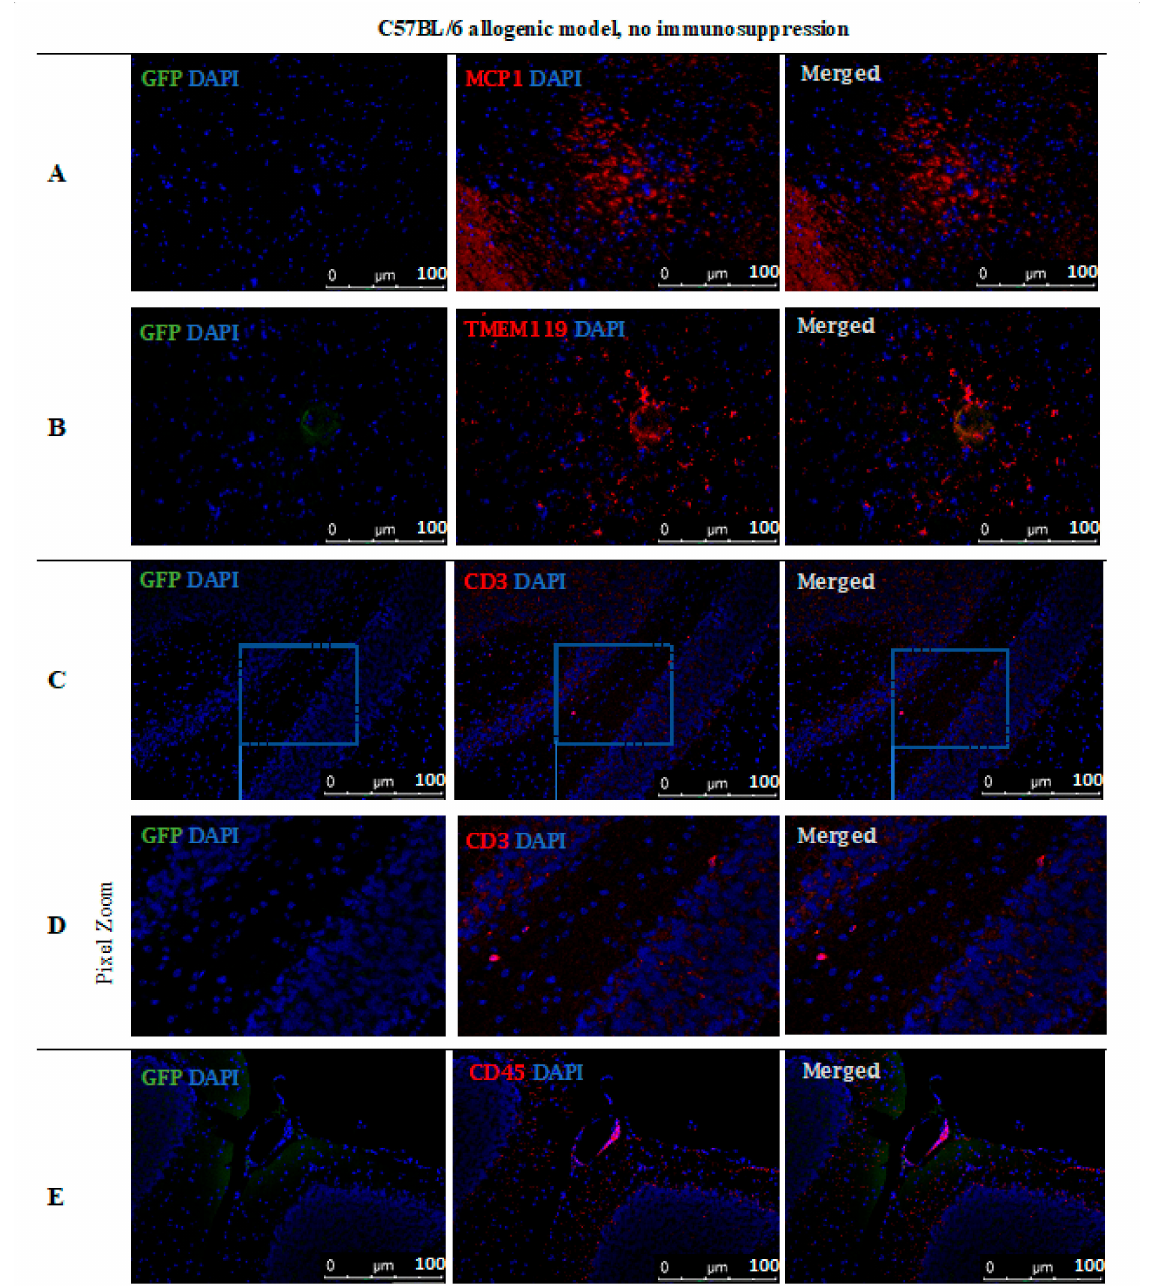
Figure 11. Post-mortem evaluation of GRPs’ graft localization in C57BL/6 allogenic model without immunosuppression applied: Immunohistochemical staining in the brain of C57BL/6 (allogeneic) mice after 14 days of observation in a group with no immunosuppression applied. The staining revealed the presence of MCP-1 in the tissue ( A ). Singular GFP+ cells aggregates were observed in tissue parenchyma surrounded by TMEM119+ microglia ( B ). The bottom picture shows infiltration of CD45+ cells into artery epithelium ( E ). Singular CD3+ cells were also present in brain parenchyma, mostly in the cerebellum, brainstem, and medulla oblongata areas ( C , D ). Abbreviations: GFP-green fluorescent protein; GRP-glial-restricted progenitor